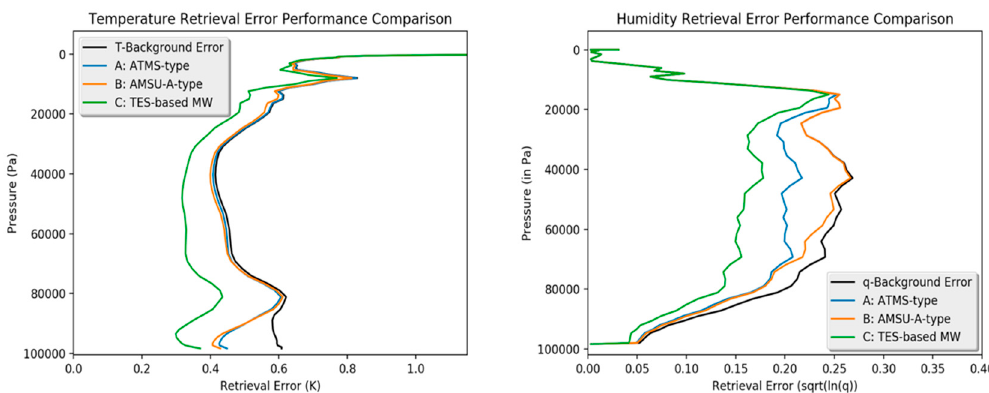
Figure 8. Temperature (in left) and Humidity (in right) retrieval error performance estimation and comparison for all three MW instrument system configurations (A (ATMS-type), B (AMSU-A-type) and C (TES-based MW)).